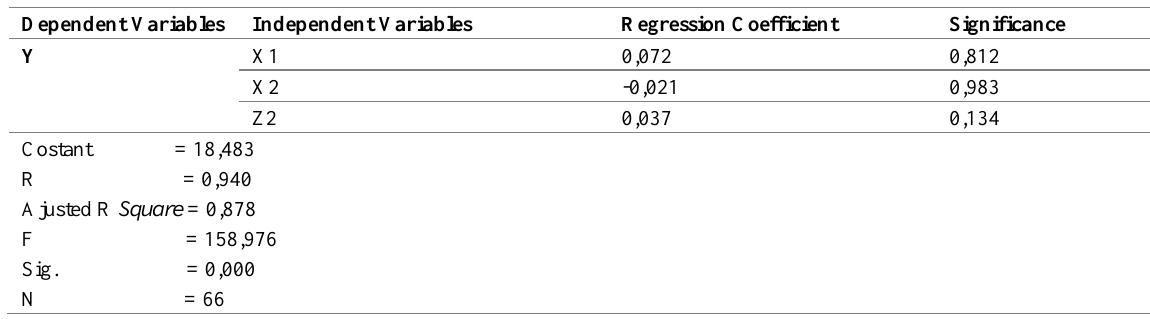
Table 5: Moderation Regression